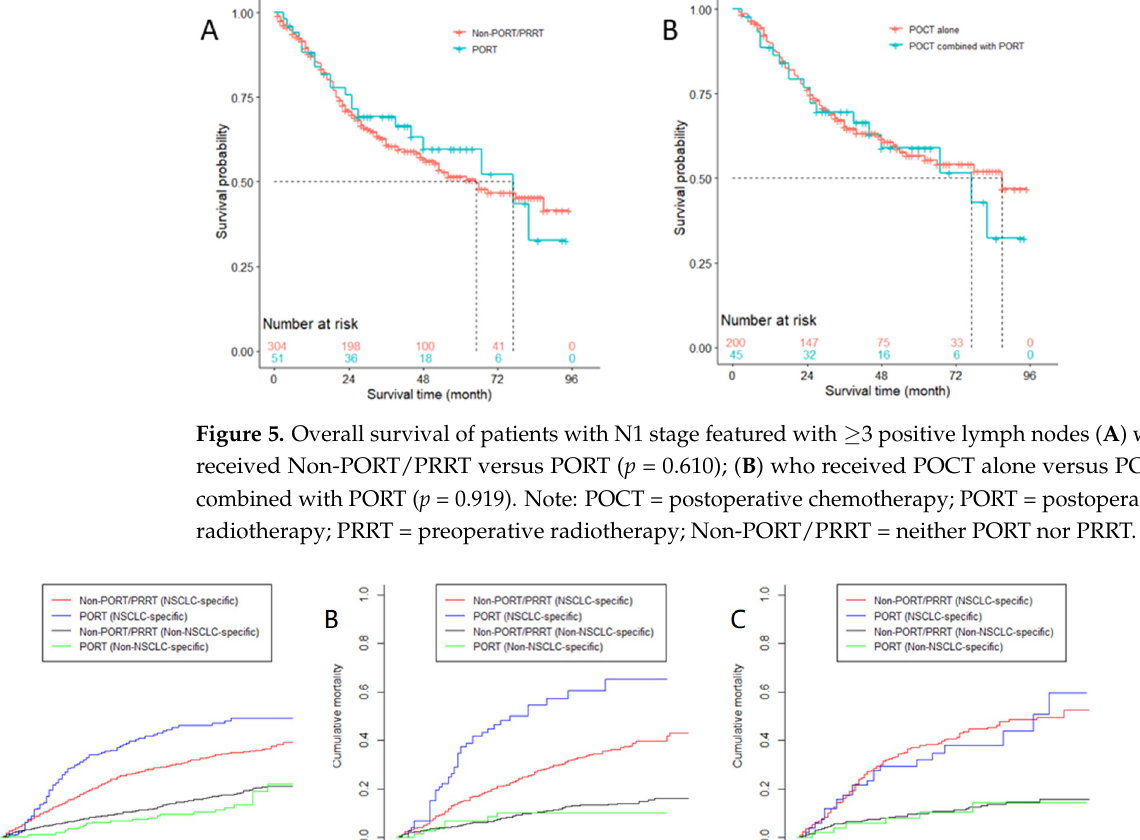
Figure 5. Overall survival of patients with N1 stage featured with ≥ 3 positive lymph nodes ( A ) who received Non-PORT/PRRT versus PORT ( p = 0.610); ( B ) who received POCT alone versus POCT combined with PORT ( p = 0.919). Note: POCT = postoperative chemotherapy; PORT = postoperative radiotherapy; PRRT = preoperative radiotherapy; Non-PORT/PRRT = neither PORT nor PRRT.